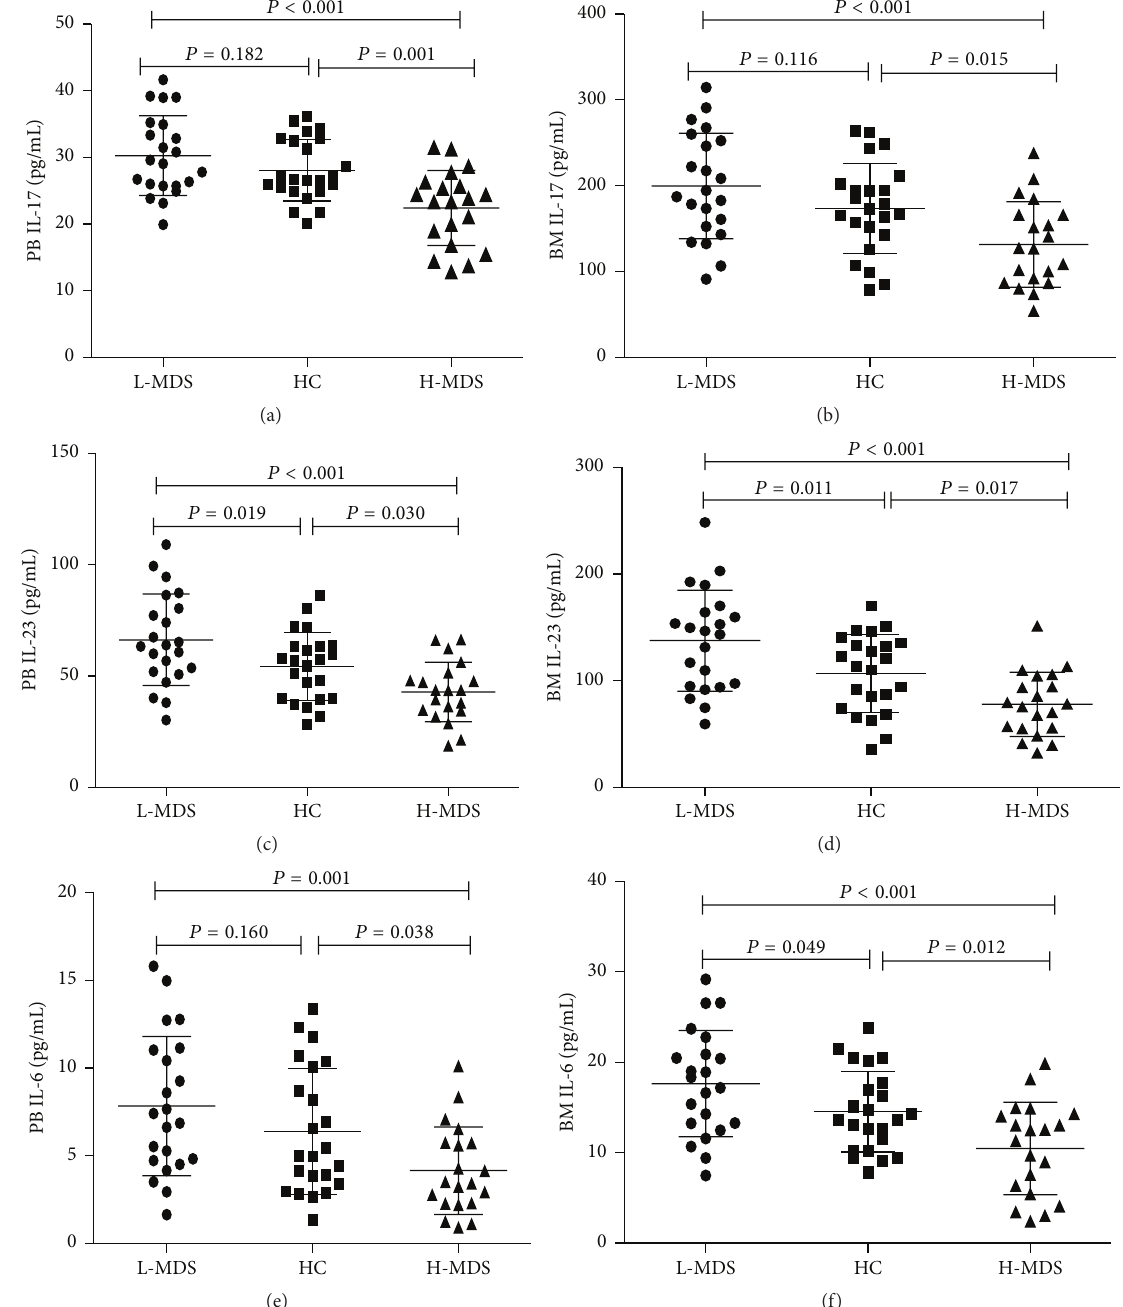
Figure 4: Differential expression of upstream cytokines might be driving the changes in Th17 numbers. PB and BM levels of IL-17 (a-b), IL-23 (c-d), and IL-6 (e-f) in L-MDS, HC, and H-MDS groups were measured by